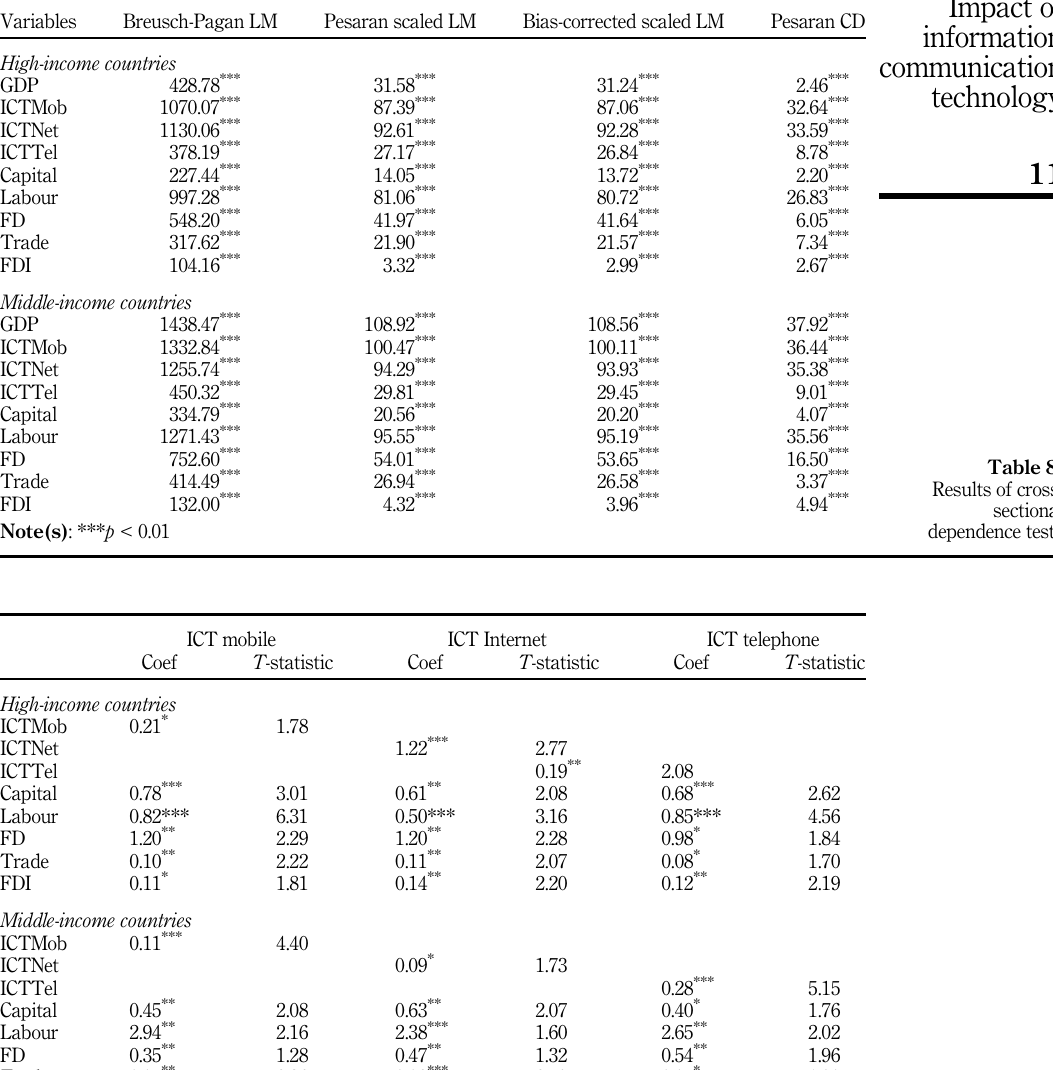
Table 9. Results of CCEMG